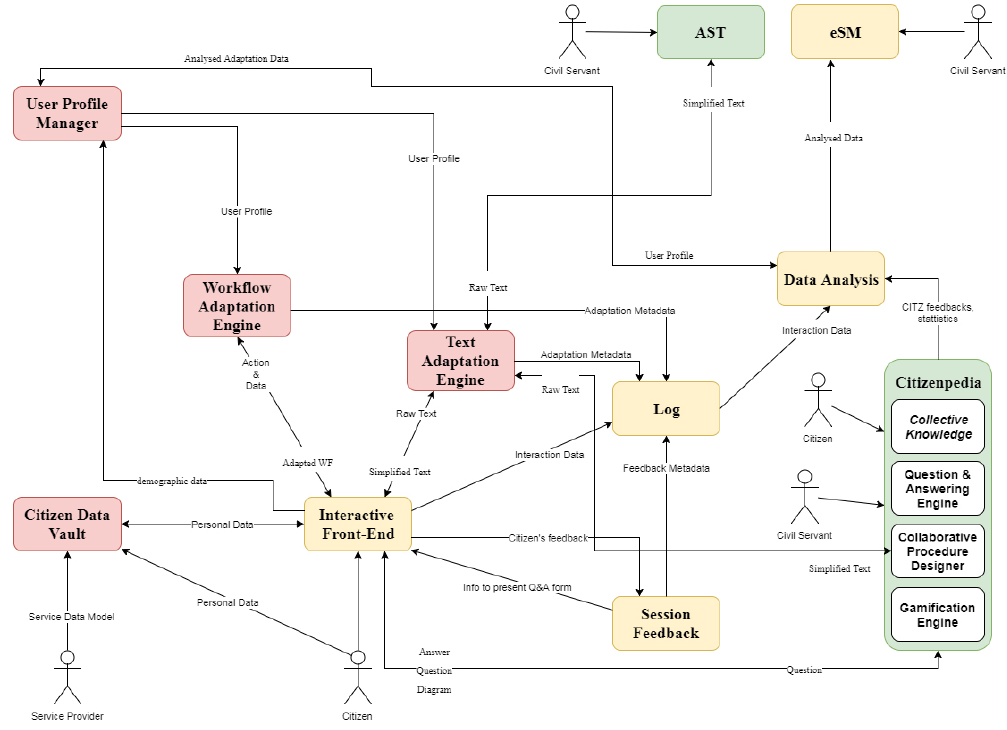
Figure 2. SIMPATICO logical